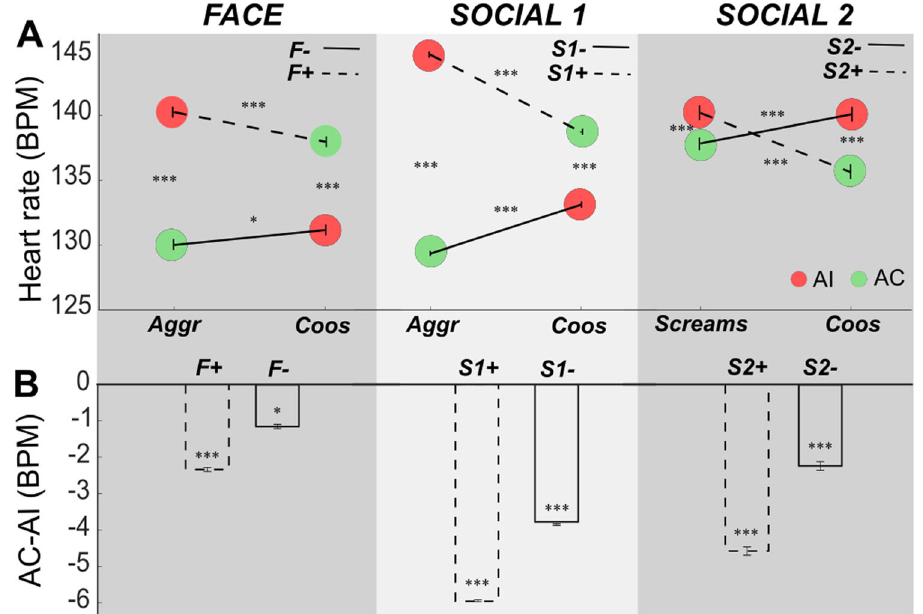
Fig. 6 | Context-related heart rate (BMP)variations.A Absolute heartrate (BMP. beats per minute) during the congruent (green) and incongruent (red) auditory blocks of each task. Dashed lines correspond to the positive af fi liative context (F+, S1+ and S2+) as de fi ned by the visual stimuli. whereascontinuous lines refer to the negative aggressive (F − and S1 − ) or escapecontexts (S2 − ).Contexts are de fi nedby pairs involving the same vocalisation categories but different visual stimuli, as de fi ned in Fig. 1b. There is a general context effect on heart rate (Friedman non- parametric test, X 2(253) =437.8, p =6.7e-286).Thereis a signi fi cant difference of HR for a same sound as a function of the context (Wilcoxon paired two-sided non- parametric test, all n =127, aggressive calls between the F+ and F − contexts: Z =13.77, p =3.6e-43,Cohen ’ sd:16.3andS1+andS1 − : Z =13.82, p =1.8e-43,Cohen ’